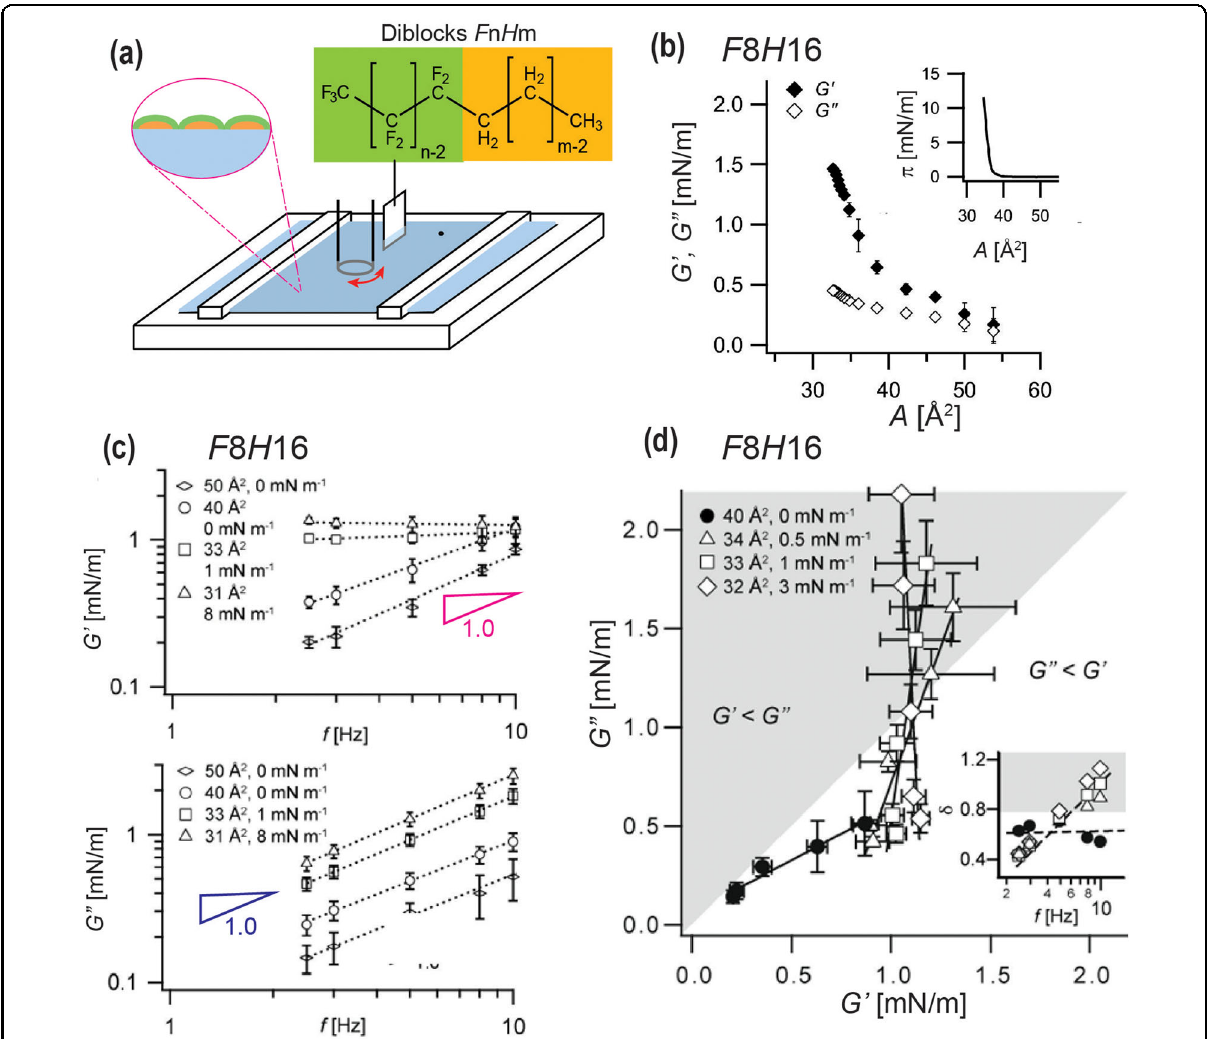
Fig. 3 Mesoscopic domains of FnHm forming a two-dimensional network (gel) even at zero pressure. a Interfacial stress rheometry experimental setup. b The typical storage modulus G ′ and loss modulus G ″ are predominantly elastic ( G ’ > G ” ) of the F n H m monolayer ( n = 8, m = 16). The corresponding isotherm shown in the inset indicates the monolayer under all conditions. c Frequency dispersion of the F 8 H 16 monolayer showed that G ′ ∝ f 1 and G ′′ ∝ f 1 at π = 0 mN/m, which is a characteristic of soft glassy matter. At π > 0, the power law exponents change to those of the Kelvin – Voigt solid, G ′ ∝ f 0 and G ′′ ∝ f 1 . d Plot of G ″ against G ′ for the F 8 H 16 monolayer acquired at different f values. The inset is the phase angle δ plotted against the frequency, indicating that the monolayer is predominantly elastic over the whole frequency window at π = 0 mN/ m ( G ” < G ’ ) and that the phase shift δ remains constant at ≈ 0.6. Adapted from ref. 56